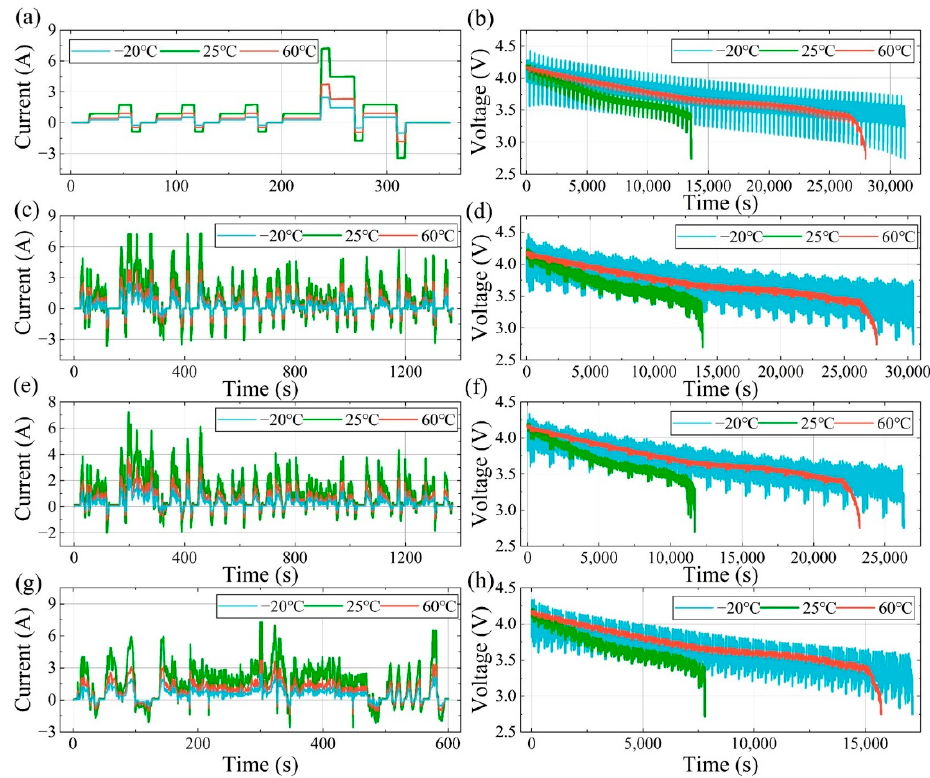
Figure 3. Voltage and current measurement under ( a , b ) DST, ( c , d ) FUDS, ( e , f ) UDDS, and ( g , h ) US06 experiments for the battery LR2170SA at different temperatures: − 20, 25, and 60 °C.